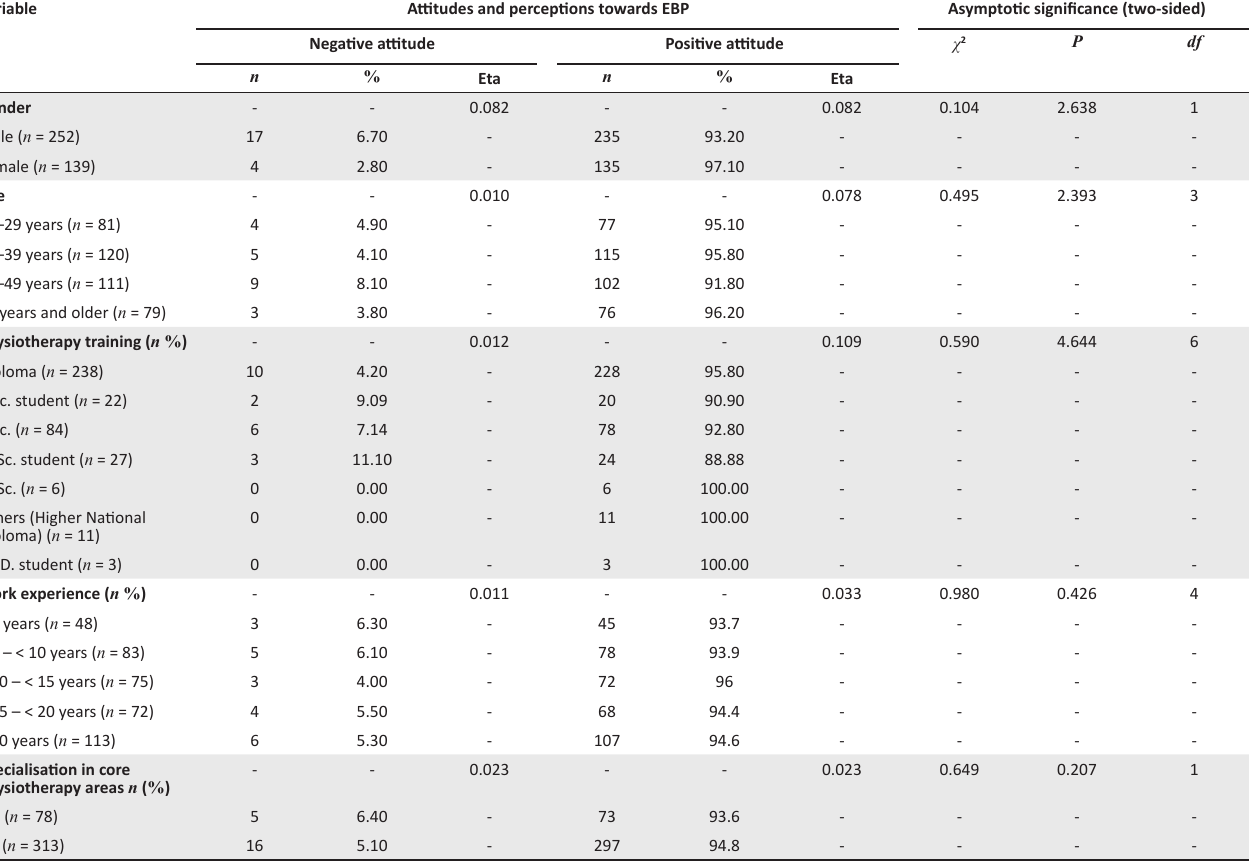
TABLE 4: Association between demographic characteristics and attitudes and perceptions regarding evidence-based practice (EBP) ( n = 391).